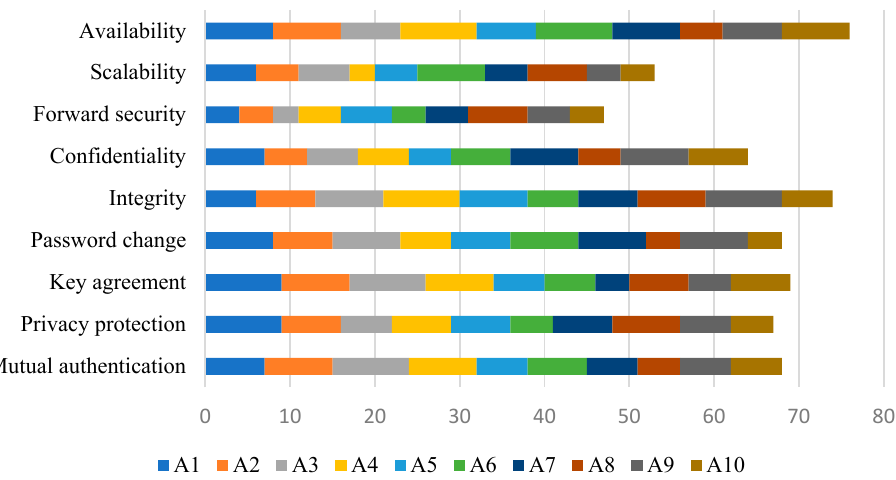
Figure 5. Performance evaluation of authentication alternatives.